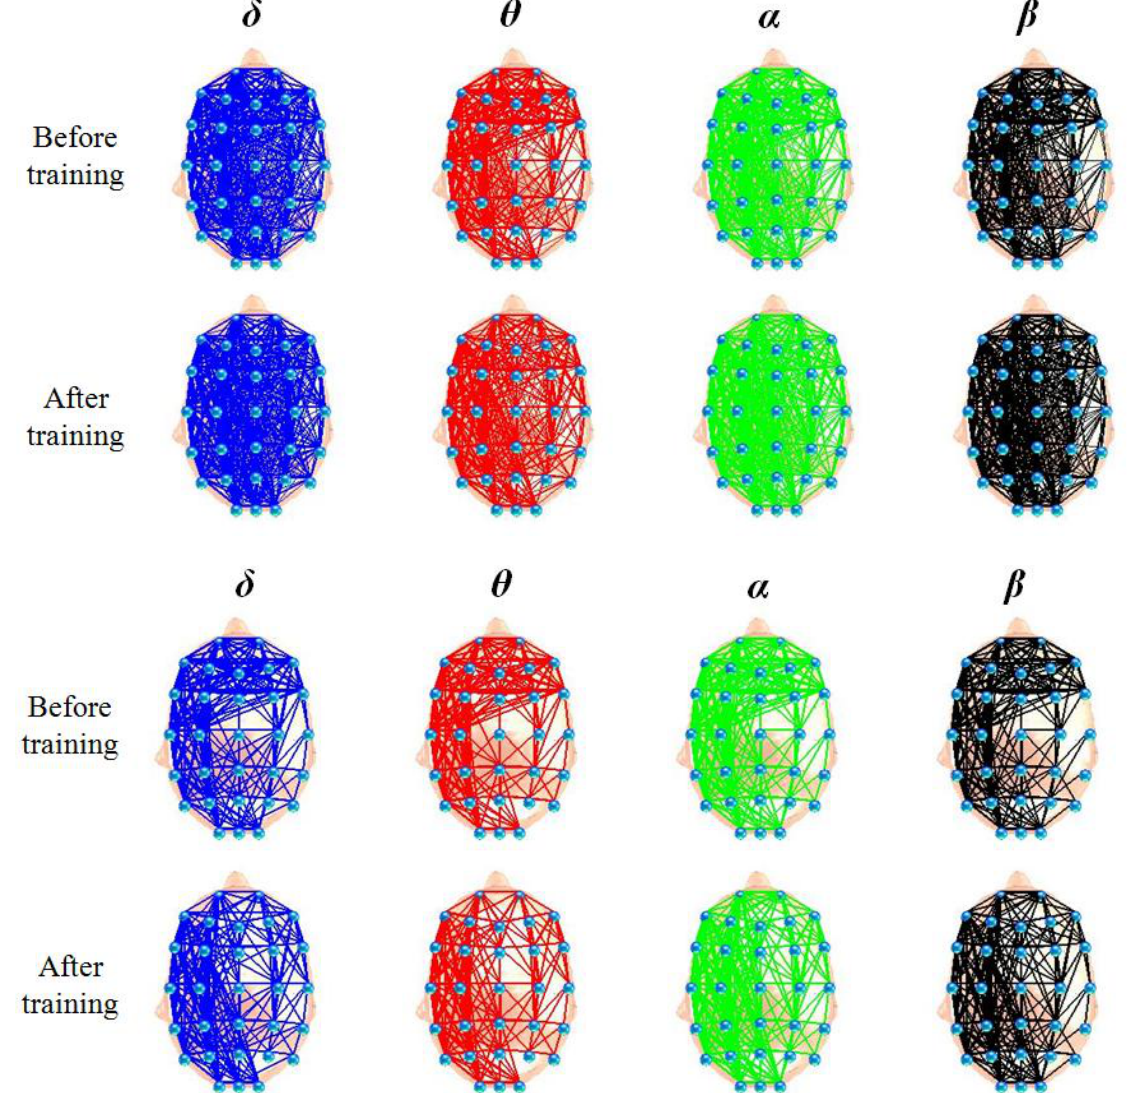
Figure 2. Functional brain networks in different frequency bands when the threshold is 0.3 and